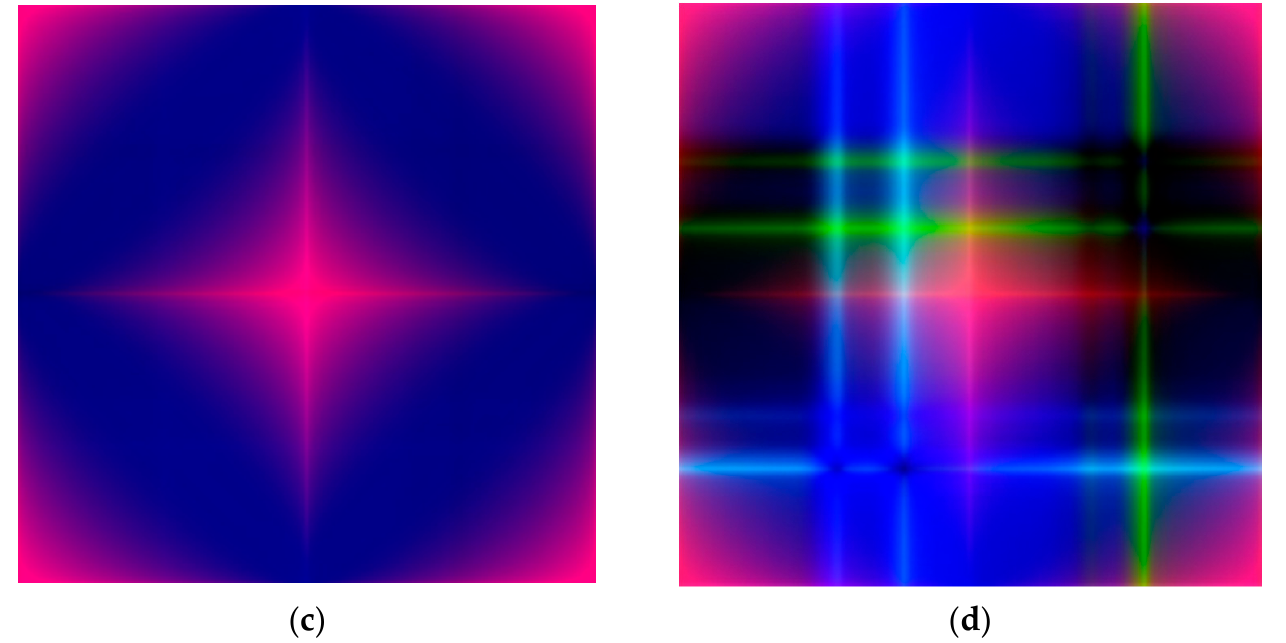
Figure 8. RGB images generated by GAF transformation of CV cycles, for the detection of: ( a ) Potassium ferricyanide (PF) in water, 0.25mM, bare SPE; ( b ) potassium ferricyanide (PF) in water, 100 mM, bare SPE; ( c ) benzoquinone (BQ) in water, 2.5 mM, SWCNT SPE; ( d ) benzoquinone (BQ) in water, 80 mM, SWCNT SPE.